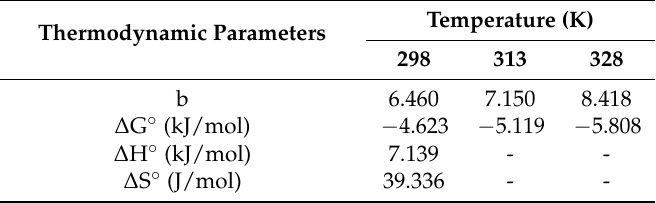
Table 8. Thermodynamic parameters for adsorption of P on concrete particles. Thermodynamic